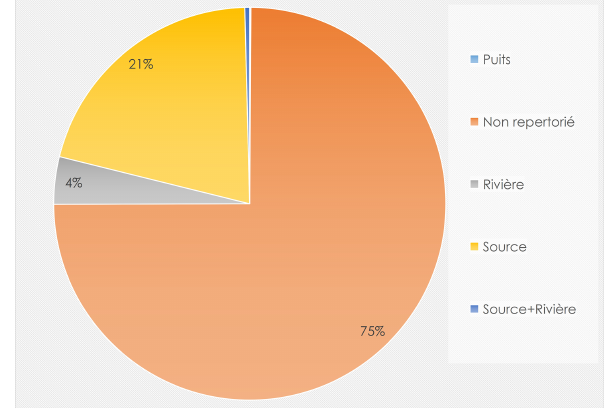
Figure 7. Répartition de la population par type de ressources dans la Commune Urbaine d’Ambositra (Direction de l’Eau Amoron’i Mania, données non publiées).